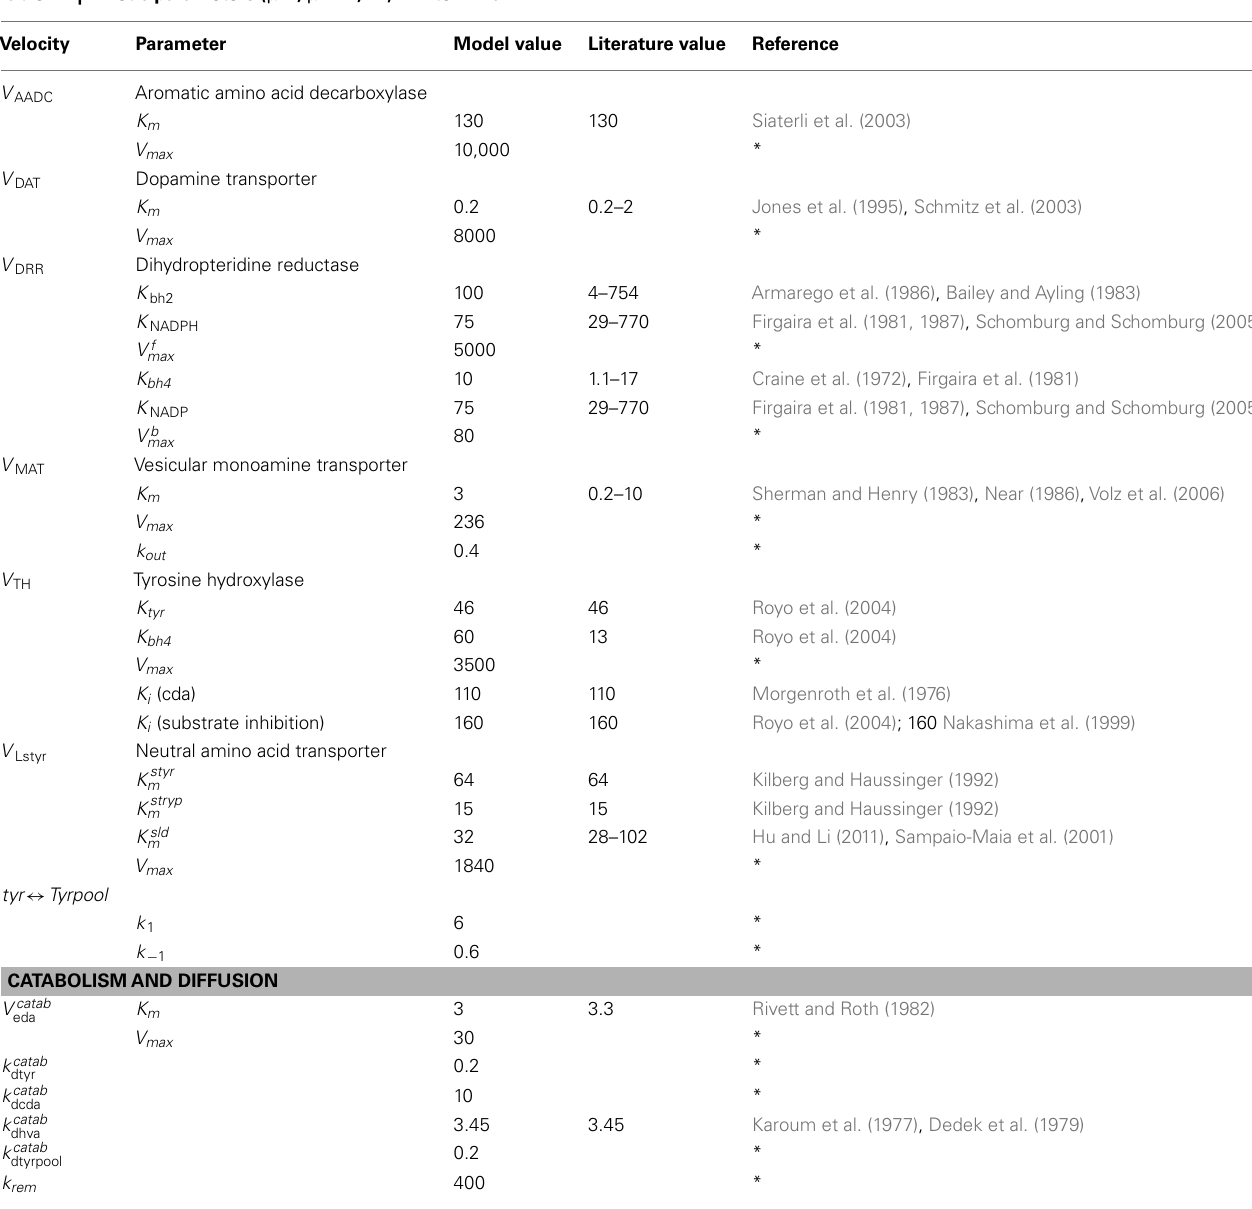
TableA4 | Kinetic parameters ( µ M, µ M/h, /h): DA